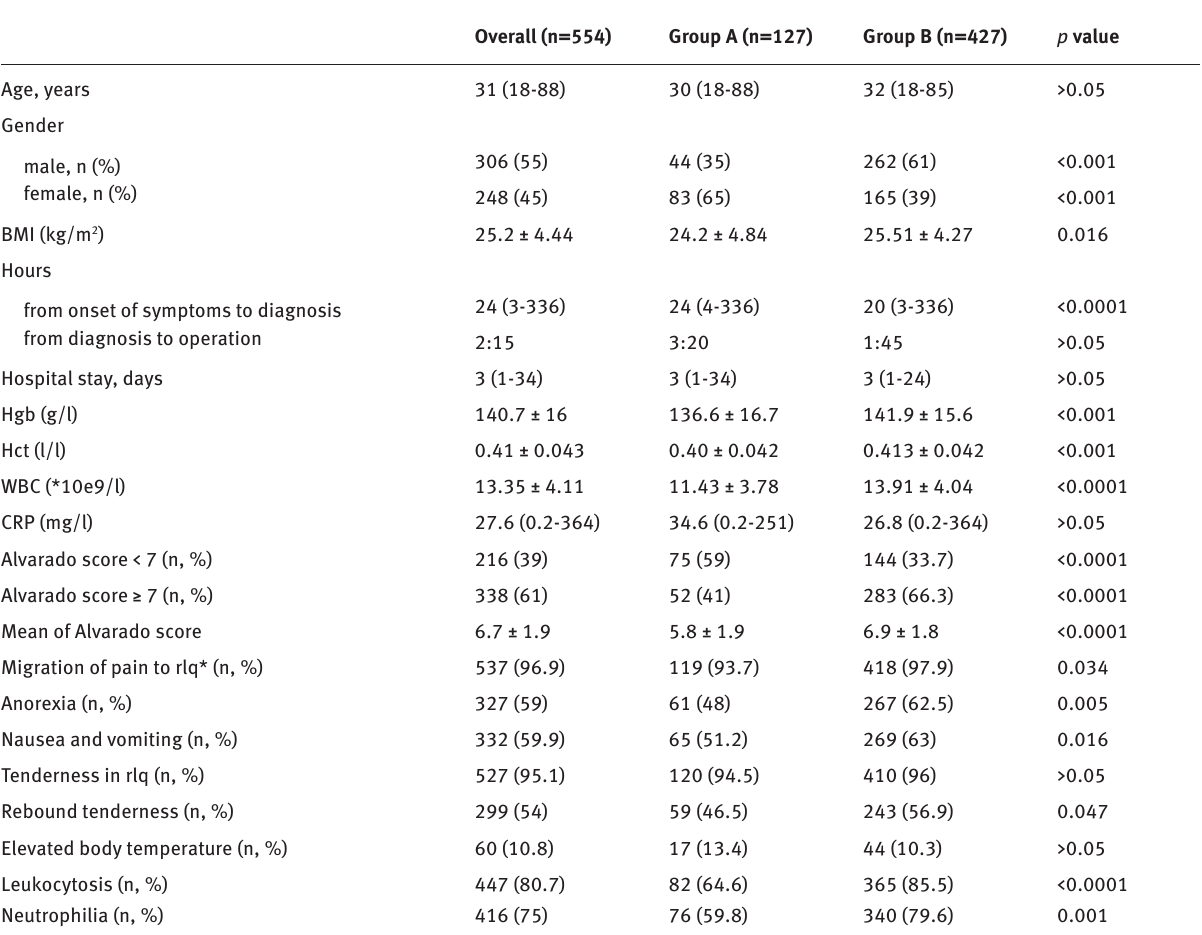
Table 1. : Demographics, clinical characteristics, preoperative laboratory tests results and Alvarado score distribution frequencies overall and between